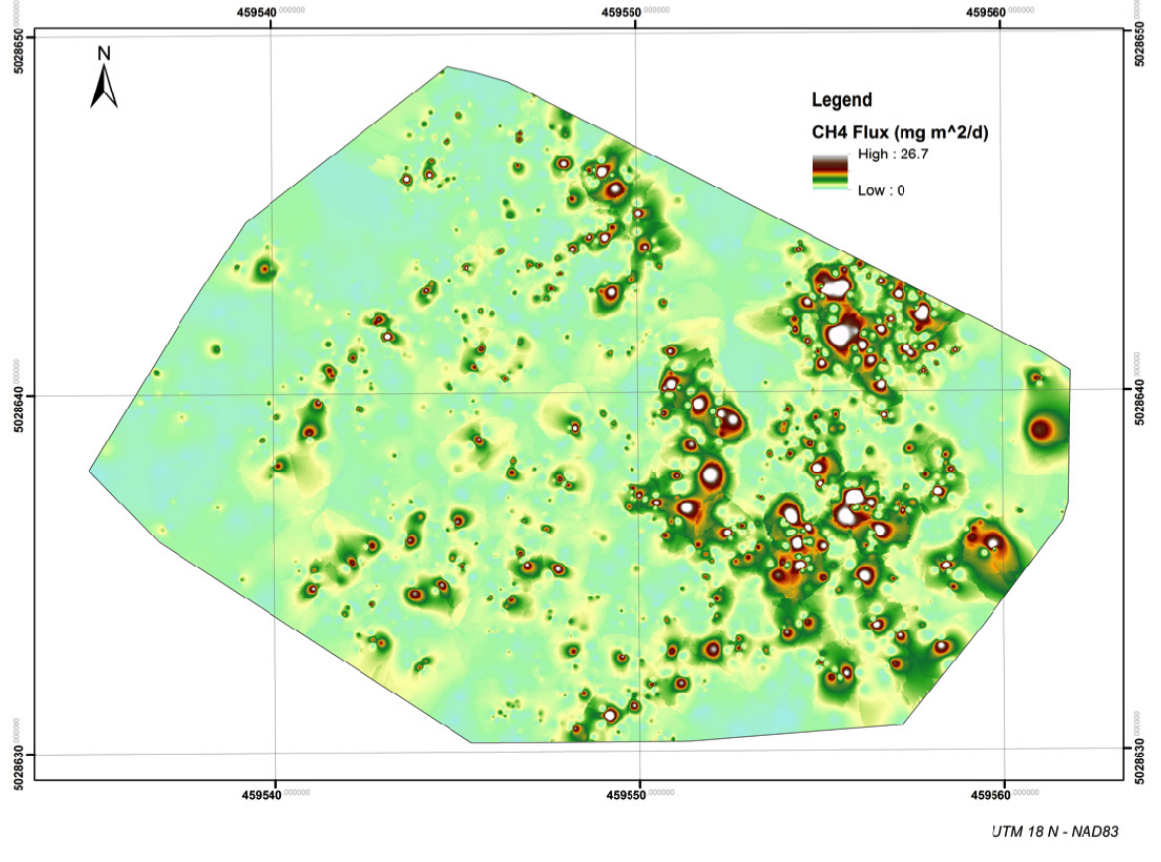
Figure 5. Example of a methane flux map interpolated from the estimated basal area of